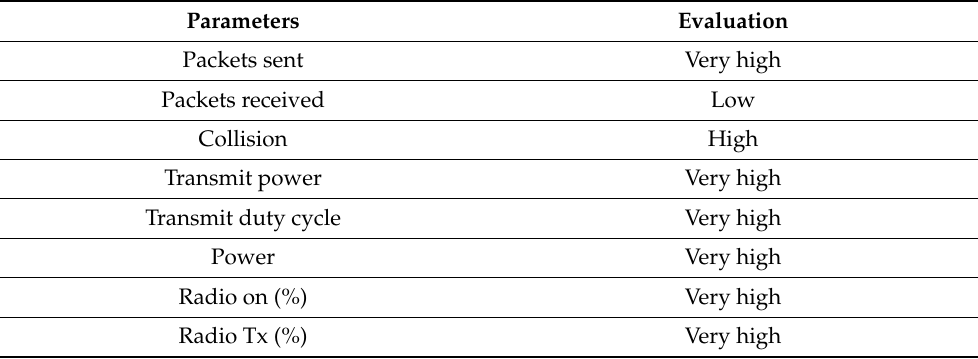
Table 1. Evaluation of greedy node parameters